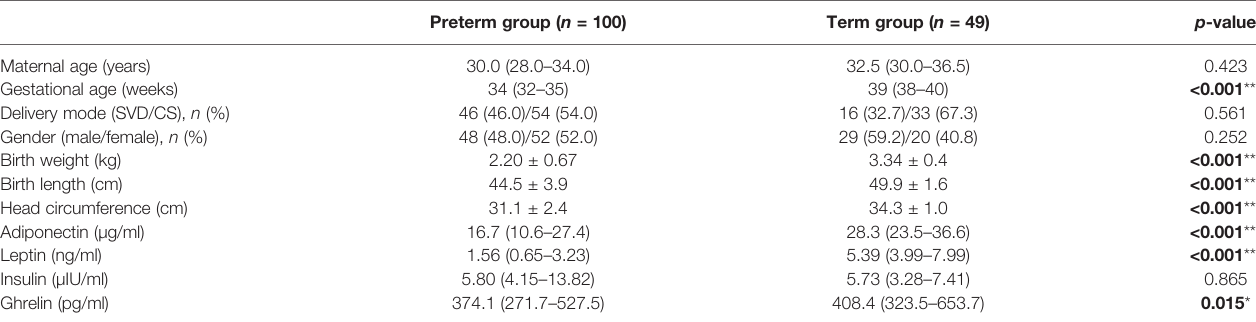
TABLE 1 | Baseline characteristics of the mother – infant pairs in the two